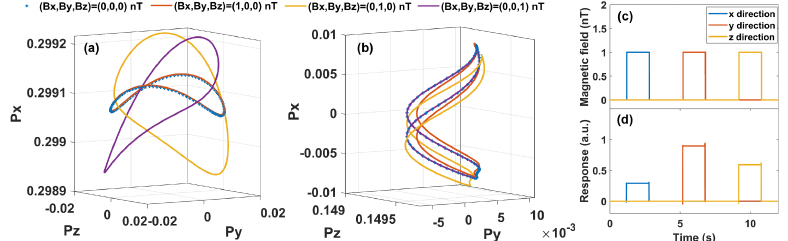
Figure 3. Response of the atomic polarization vector to the change in the static magnetic field under strong modulation. Trajectories of the polarization vector are presented in ( a ) for the atoms of P1 part and ( b ) for the atoms of P2 part within the period of ten complete cycles under different static magnetic fields. ( c ) Change in the static magnetic field. ( d ) Response of the whole atomic spin to the change in magnetic field in three